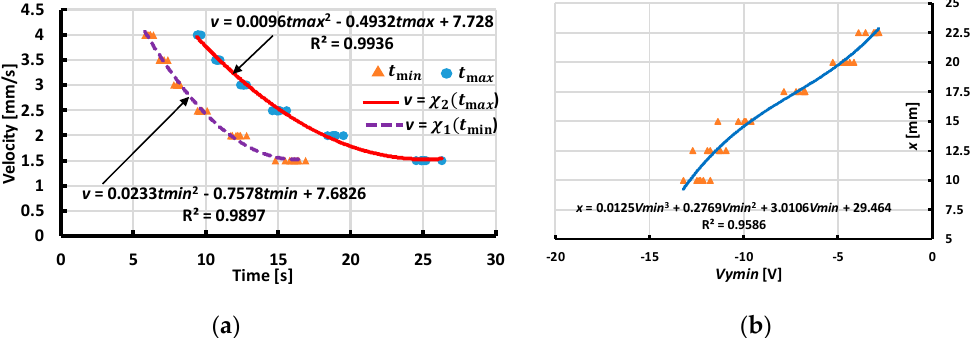
Figure 20. Interpolating velocity v ( mm/s ) and distance x ( mm ) for case of Y-sliding backward. ( a ) Interpolating velocity v from t min , t max . ( b ) Interpolating distance x from output voltage V y min .